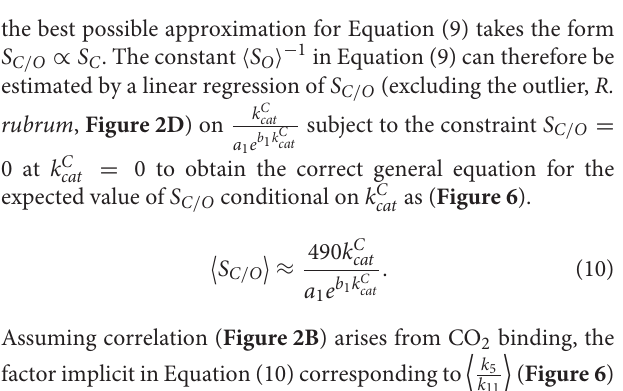
FIGURE 5 | Components of K C if correlation is due to CO 2 dissociation. (A) = K R k 5 a 1 e b 1 k C cat − k C cat , (from rearranging Equation 4) calculated γ C k 6 (cid:10) (cid:11) (cid:10) (cid:11) = 0.7 ( µ M.s) − 1 ( Figure 2B , K R k 5 assuming a constant value of (cid:10) (cid:11) a 1 = 4.5 µ M, b 1 = 0.34 s ), and (B) the corresponding components of C cat h K C D i.e., k . Both (A,B) are graphed in logarithmic scale. K R k 5 i and D E